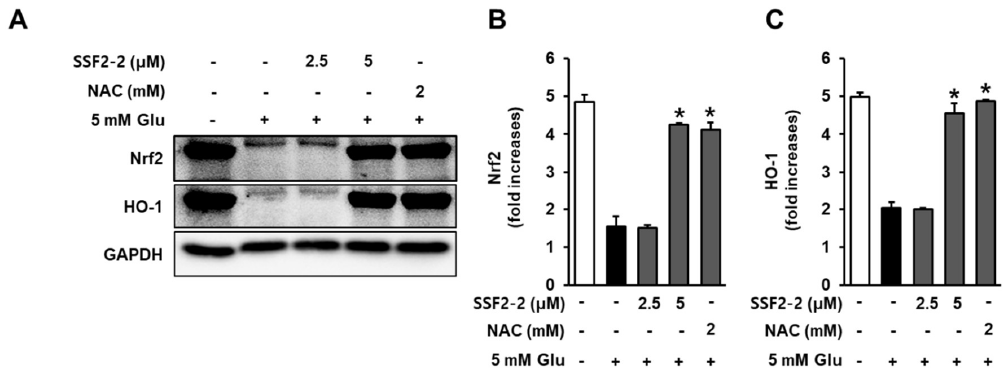
Figure 8. Effects of SSF2-2 on glutamate-induced reductions in the nuclear factor-erythroid-2–related factor 2 (Nrf2) and heme oxygenase-1 (HO-1). HT22 cells were incubated for 24 h with 5 mM glutamate (Glu) with or without compound SSF2-2 at 2.5 and 5 µ M, and then subjected to Western blot. ( A ) Protein expression of Nrf2, HO-1, and GAPDH. Fold increases in protein expression of ( B ) Nrf2 and ( C ) HO-1. Data represent the mean ± S.E.M., n = 3, * p < 0.05 compared with the glutamate-treated group.